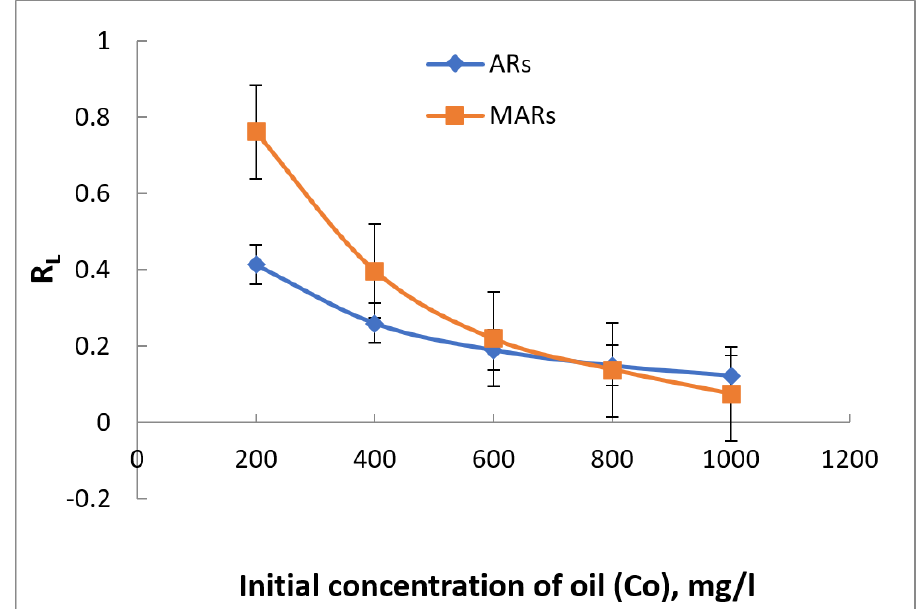
Figure 15. The values of separation factor R L at different initial concentrations of oil for the ABs and AR adsorbents.